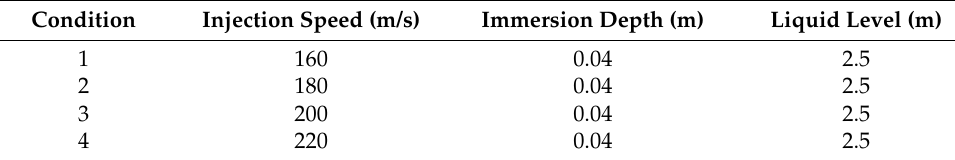
Table 2. Parameters of different injection velocity working condition groups.